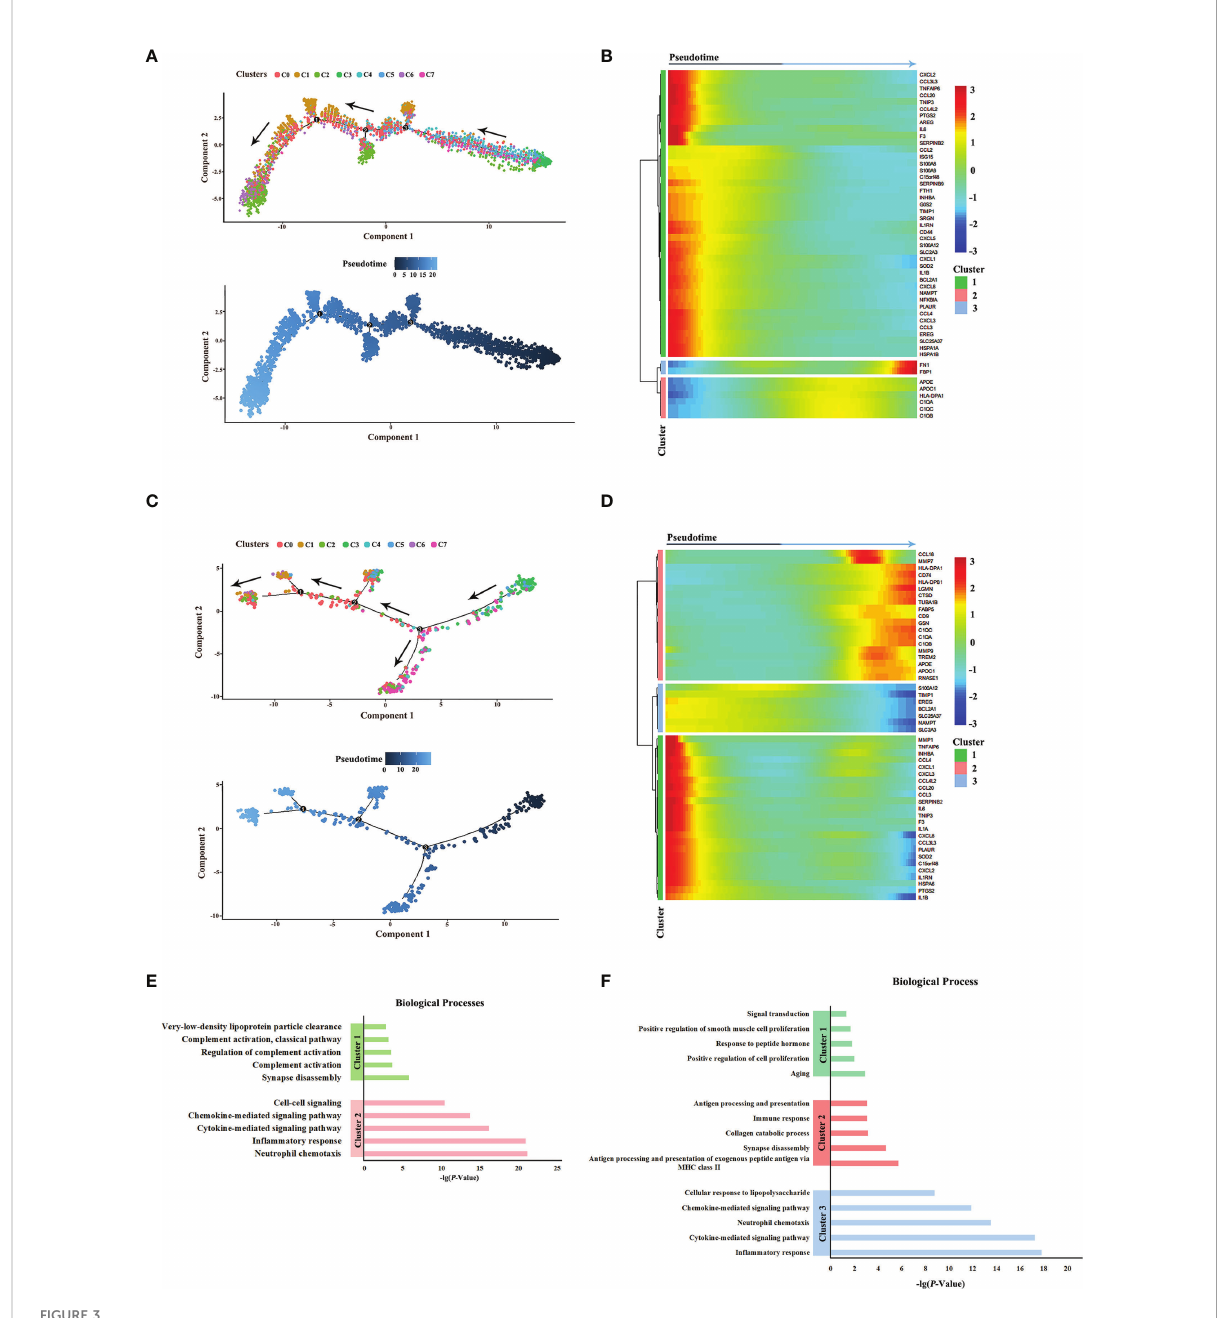
FIGURE 3 Pseudotime analysis of macrophage subsets in HPV +/- HNSCC. (A) Simulated differentiation trajectory analysis of macrophage subsets in HPV - HNSCC. Each point corresponds to a single cell, and each color represents a macrophage cell cluster. (B) The heatmap of the expression of the top 50 genes with the pseudotime value in HPV - HNSCC. The genes with a similar expression trend converge to form different clusters. (C) Simulated differentiation trajectory analysis of macrophage subsets in HPV + HNSCC. (D) The heatmap of the expression of the top 50 genes with the pseudotime value in HPV + HNSCC. (E) Functional enrichment analysis of different clusters in HPV - HNSCC. (F) Functional enrichment analysis of different clusters in HPV +